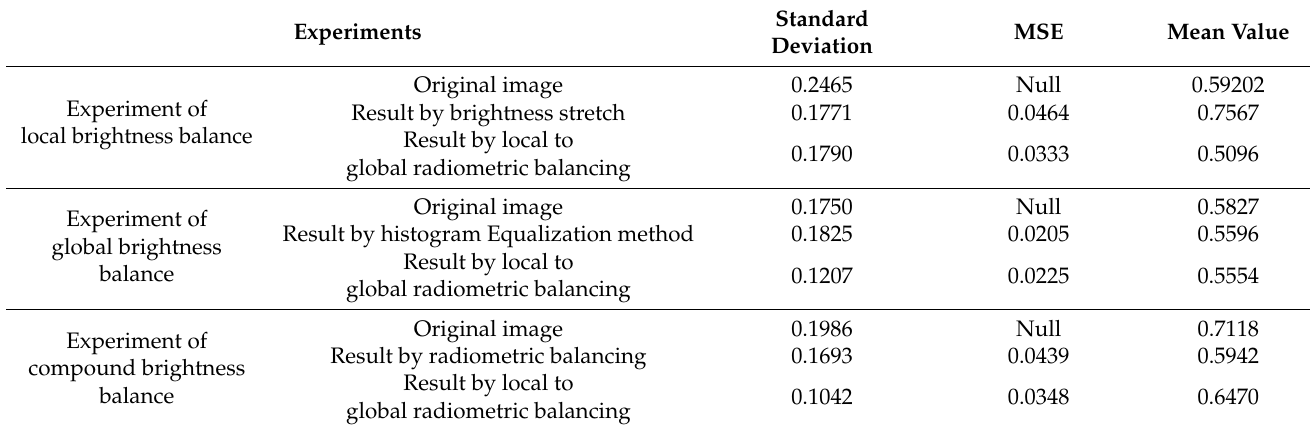
Table 3. The index of results by different